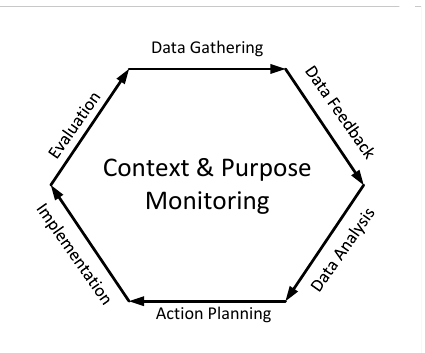
Figure 2. Steps for implementing action research (Adapted from [38]).